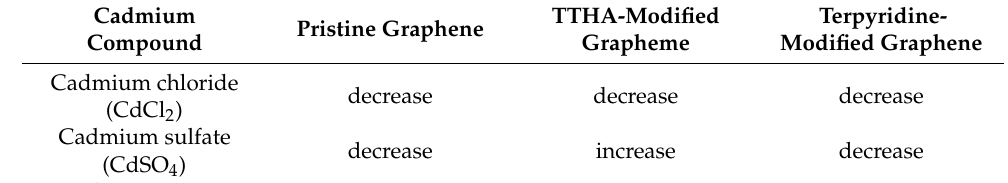
Table 1. Drain-current response of the sensors to each cadmium compound.